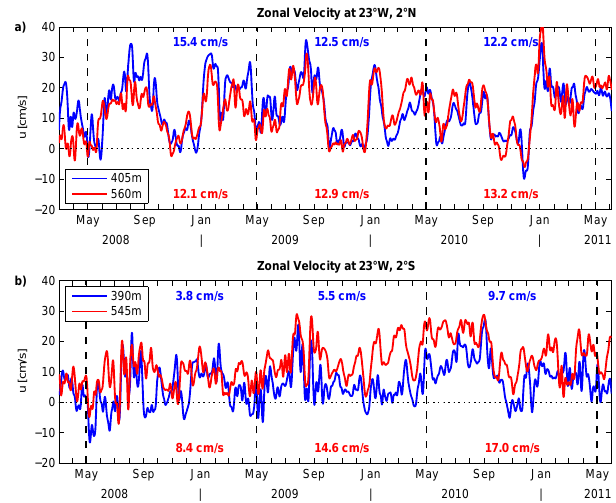
Figure 15. Zonal velocity from moored observations at 23 ◦ W, 2 ◦ N (a) and 23 ◦ W, 2 ◦ S (b) at about 400m (blue lines) and 550m (red lines). Blue and red numbers represent annual mean velocities at about 400 and 550m in depth, respectively. Dashed vertical lines mark time periods used for the calculation of annual means; dotted horizontal line marks zero